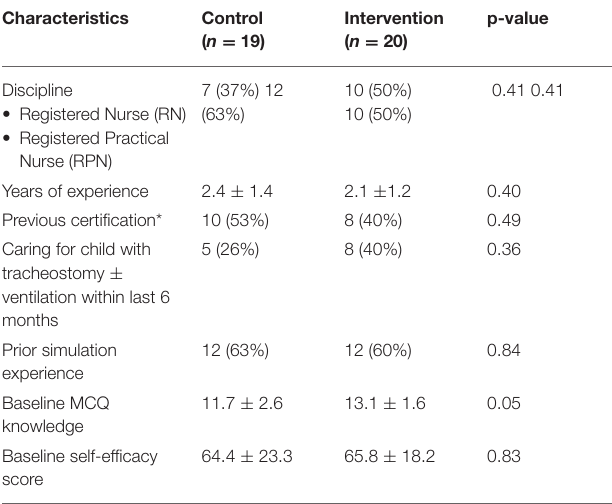
TABLE 1 | Baseline characteristics.